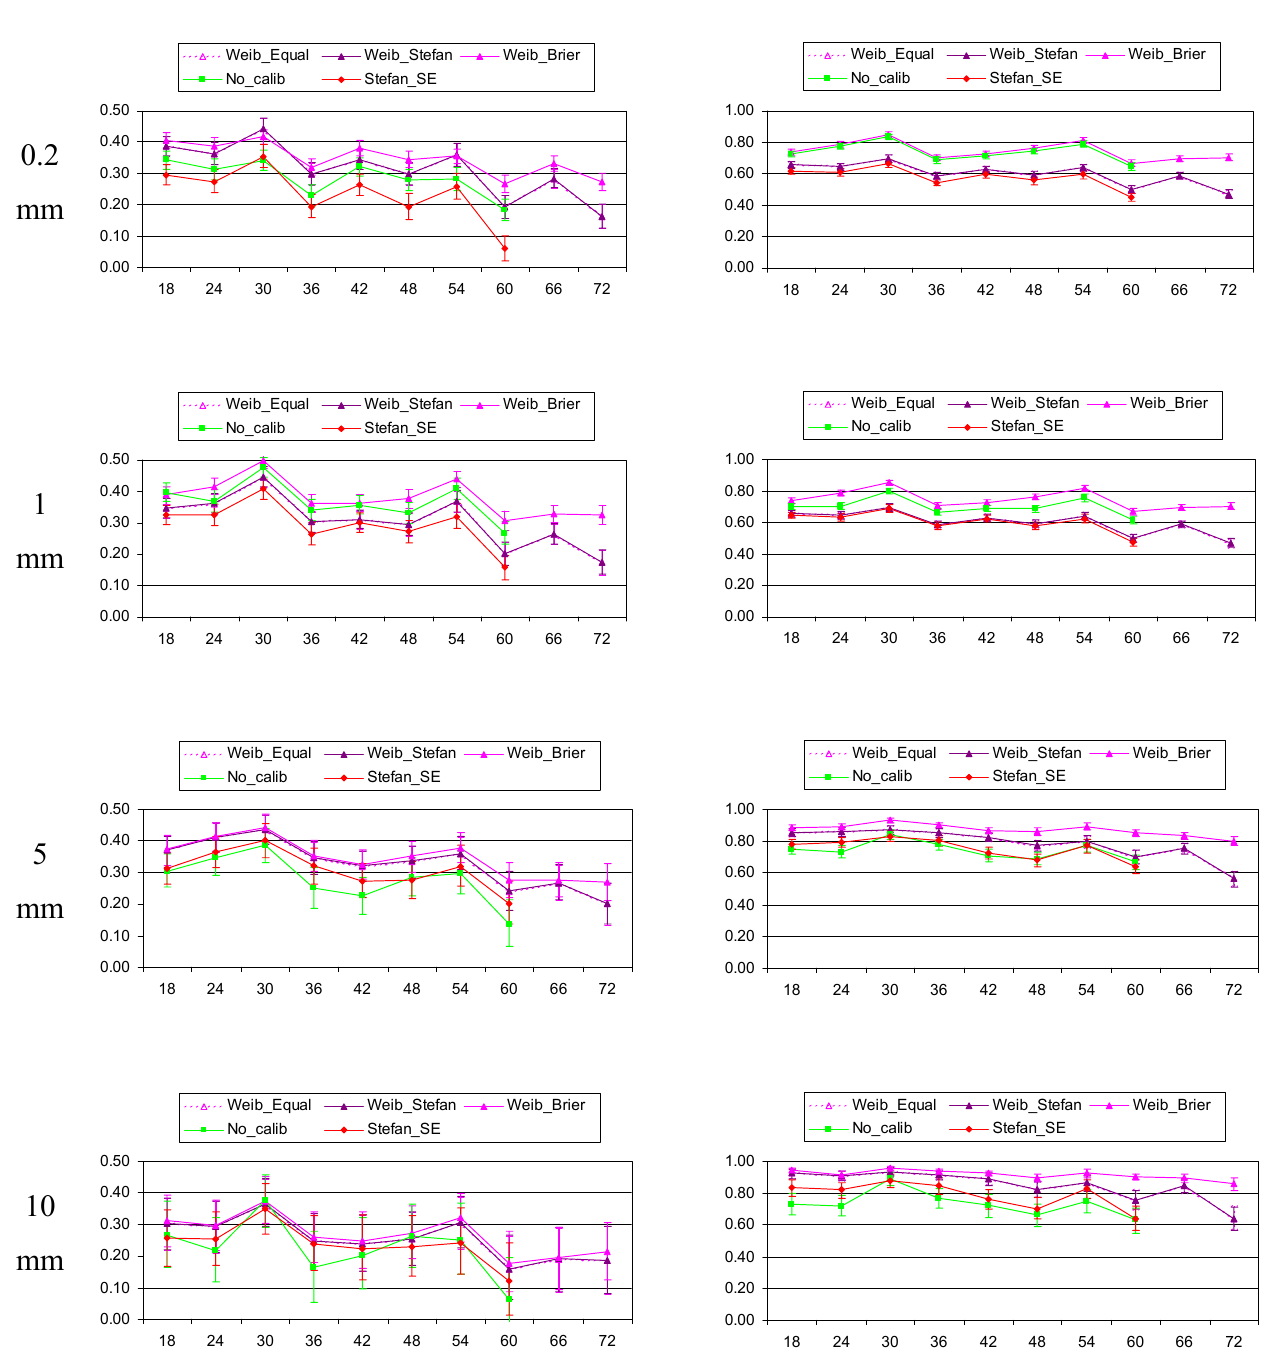
Fig. 4. Comparison of the Brier Skill Score (left-side panels) and the ROC Area Skill Score (right-side panels) results for the average precipitation values, calculated using the 0.2-, 1-, 5- and 10-mm thresholds, for the different ensembles: the Weibull-based approach with the Stefanova weights (purple line), the Brier score-based weights (pink line) and the equal weights (pink dashed line); the not-calibrated ensemble (green line); and the Stefanova ensemble (red